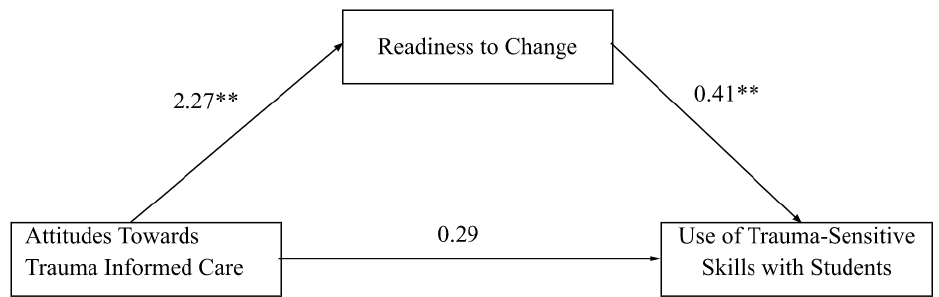
Figure 1. Standardized Regression Coefficients for the Relationship Between Attitudes Toward Trauma-Informed Care and Use of Trauma-Sensitive Skills as Mediated by Readiness to Change. p < 0.05 *, p < 0.01